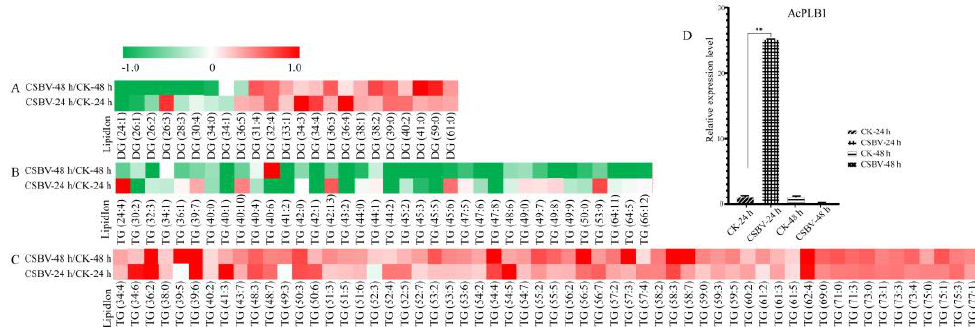
Figure 5. Lipid species of DG and TG were more induced during the CSBV infection process. ( A ) Heatmap showing the DG change of both CSBV_24 h vs. CK_24 h and CSBV_48 h vs. CK_48 h; ( B ) heatmap showing the down-regulation of TG in CSBV_24 h vs. CK_24 h or CSBV_48 h vs. CK_48 h; ( C ) hatmap showing the up-regulation of TG in both CSBV_24 h vs. CK_24 h and CSBV_48 h vs. CK_48 h; ( D ) the expression levels of phospholipidase B1 post infection of CSBV and control by quantitative real-time PCR. ** indicates p -value of <0.01.